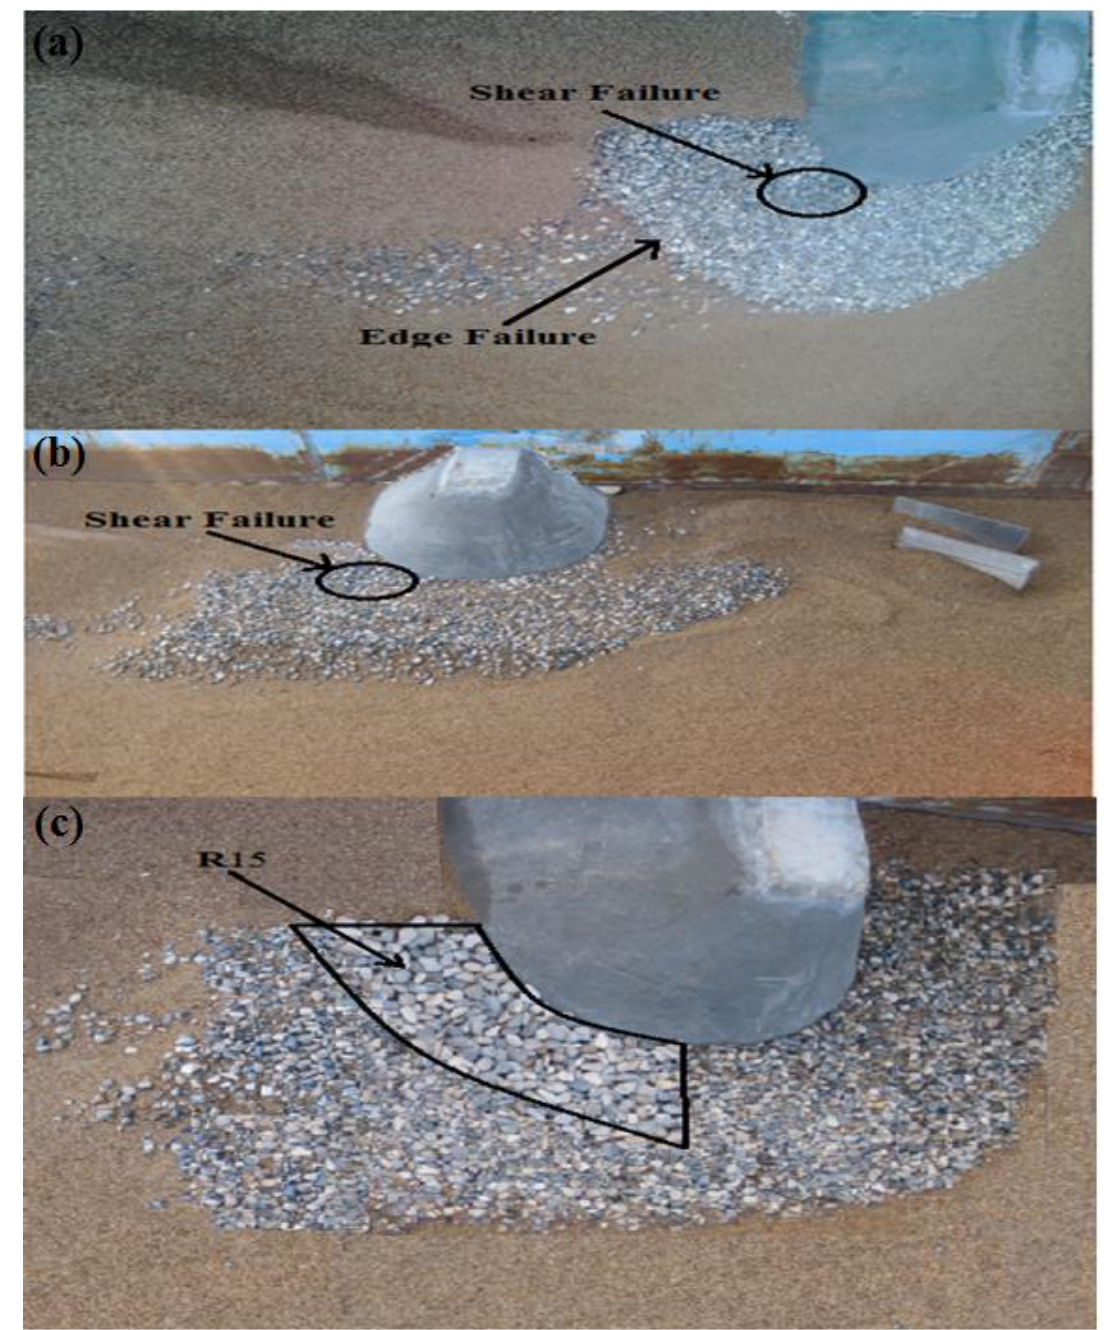
Figure 9. ( a ) T 19 : shear and edge failure; ( b ) T 7 : effect of vane on shear failure; ( c ) T 8 : use of R 15 to arrest shear failure (flow from right to left).